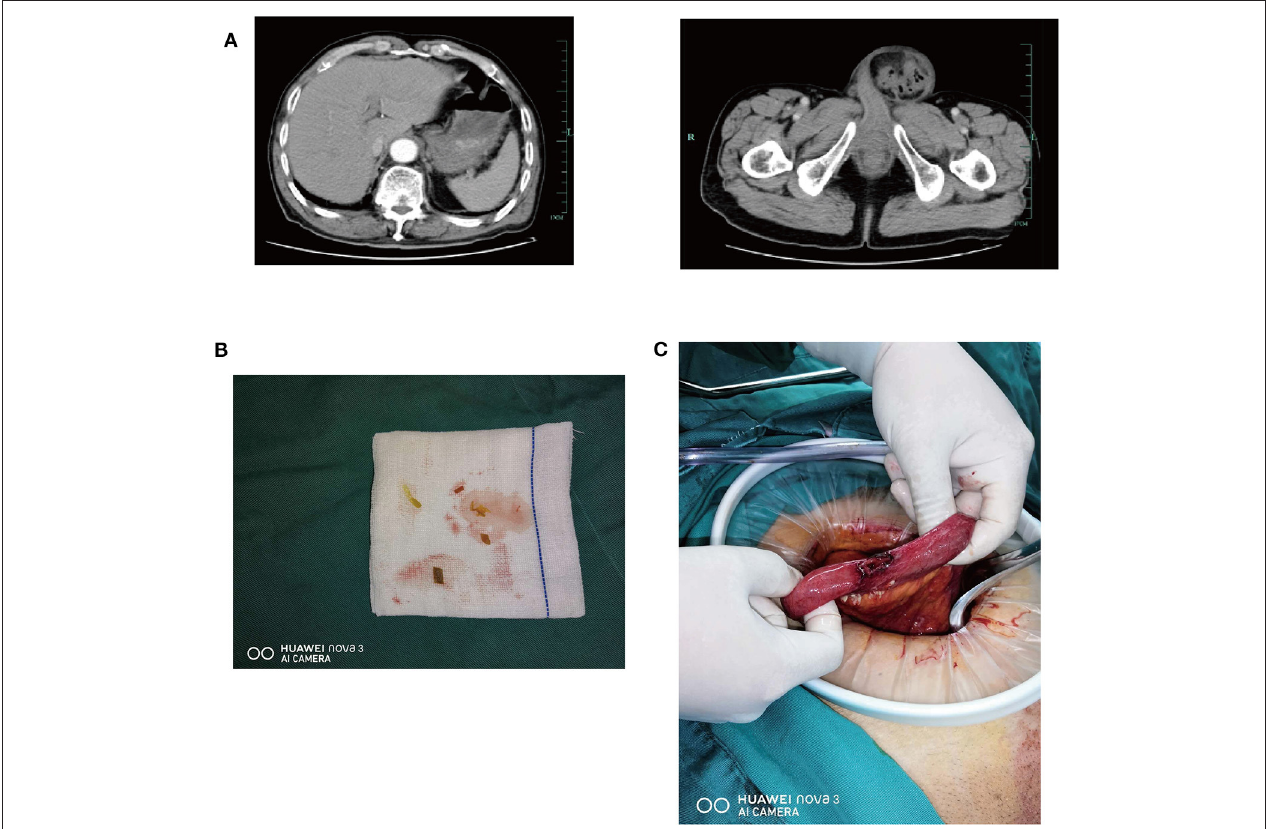
FIGURE 1 | (A) Contrast enhanced CT of the abdomen in a 77-year-old male with a non-abdomen trauma. In the left CT photograph of the upper abdomen, no free abdominal gas has been found. In the right CT photograph of the pelvis, the hernia contents of the left incarcerated inguinal hernia can be seen clearly. (B) A small amount of food in ascites can be seen in the left groin which suggests the possibility of perforation of the intraperitoneal intestine. (C) In the middle part of the small intestine, there was a laceration of about 1.0cm with obvious adhesion of purulent